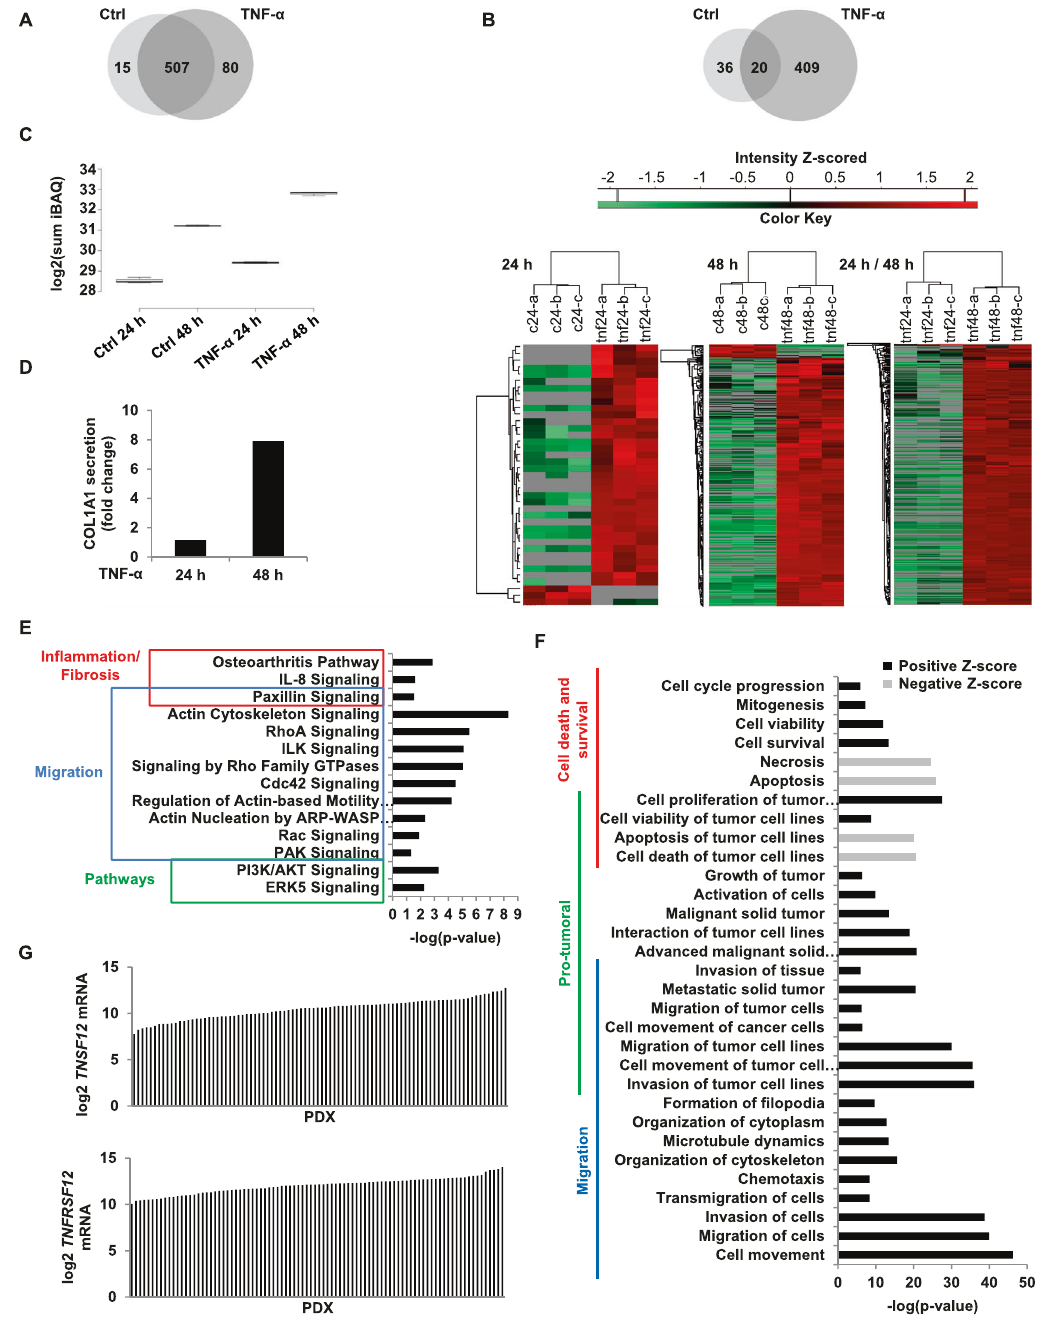
Fig. 6 Analysis of HMVECs secretome induced by TNF- α . HMVECs were treated for 24 h and 48 h with 100 ng/ml of TNF- α and supernatants were analysed by mass spectrometry. A The Venn diagram presents proteins detected in HMVECs secretome treated or not with TNF- α . In total, 602 proteins were detected whose 15 only in HMVECs secretome, 80 only in HMVEC ’ s secretome treated with TNF- α and 507 were common to both. B The Venn diagram depicting total protein distribution, 20 proteins were not signi fi cantly different between subpopulations, 36 and 409 were signi fi cantly elevated in the endothelial and mesenchymal subpopulations, respectively, using a 1.5 cut-off for signi fi cant differences. Heatmap of proteins differentially expressed between Ctrl and TNF- α at 24 h and 48 h and between TNF- α 24 h and TNF- α 48 h. Results were obtained with three technical replicates. C , D TNF- α induces an increase of secretory capacity of HMVECs as revealed by the sum of abundance intensity (iBAQ) for all identi fi ed proteins ( C ) and an increase of COL1A1 secretion ( D ). E , F All proteins detected at 48 h of TNF- α treatment were analysed with IPA. Pathways ( E ) and functions ( F ) signi fi cantly affected are represented by the graphs. G mRNA expression levels of TNSF12 and TNFRSF12 in PDXs. HMVECs human microvascular endothelial cells, TNF- α tumour necrosis factor- α , Ctrl control, COL1A1 collagen type I α 1, TNFSF12 tumour necrosis factor ligand superfamily member 12, TNFRSF12 tumour necrosis factor receptor superfamily member 12, PDXs patient-derived